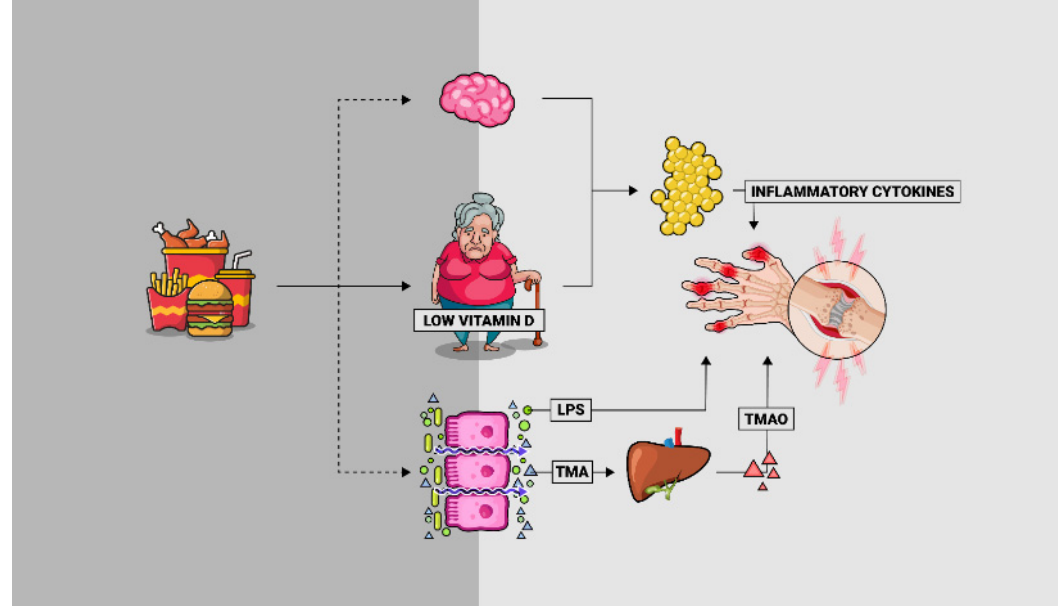
Figure 1. Cross-talk between diet-associated dysbiosis and hand osteoarthritis pathophysiology. A poor lifestyle, coupled with an inadequate energy balance over the years, causes increased adiposity and obesity-derived gut dysbiosis. The permeable gut, colonized by an unfavorable microbiota, leads to increased concentrations of circulating pro-inflammatory molecules such as LPS and metabolites such as TMAO that could have an impact on the aberrant inflammatory process which characterizes hand osteoarthritis. Additionally, the growing adipose tissue secretes pro-inflammatory cytokines that negatively modulate this process. LPS: lipopolysaccharide; TMA: trimethylamine; TMAO: trimethylamine-N-oxide.